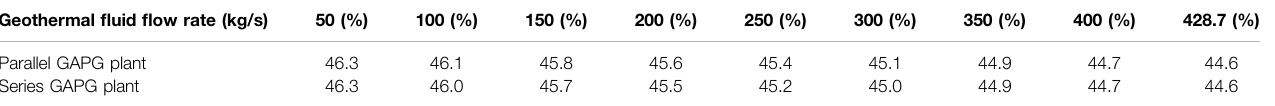
TABLE 4 | Hybrid ef fi ciencies of two kinds of GAPG plant with different amount of geothermal energy integration. Geothermal fl uid fl ow rate